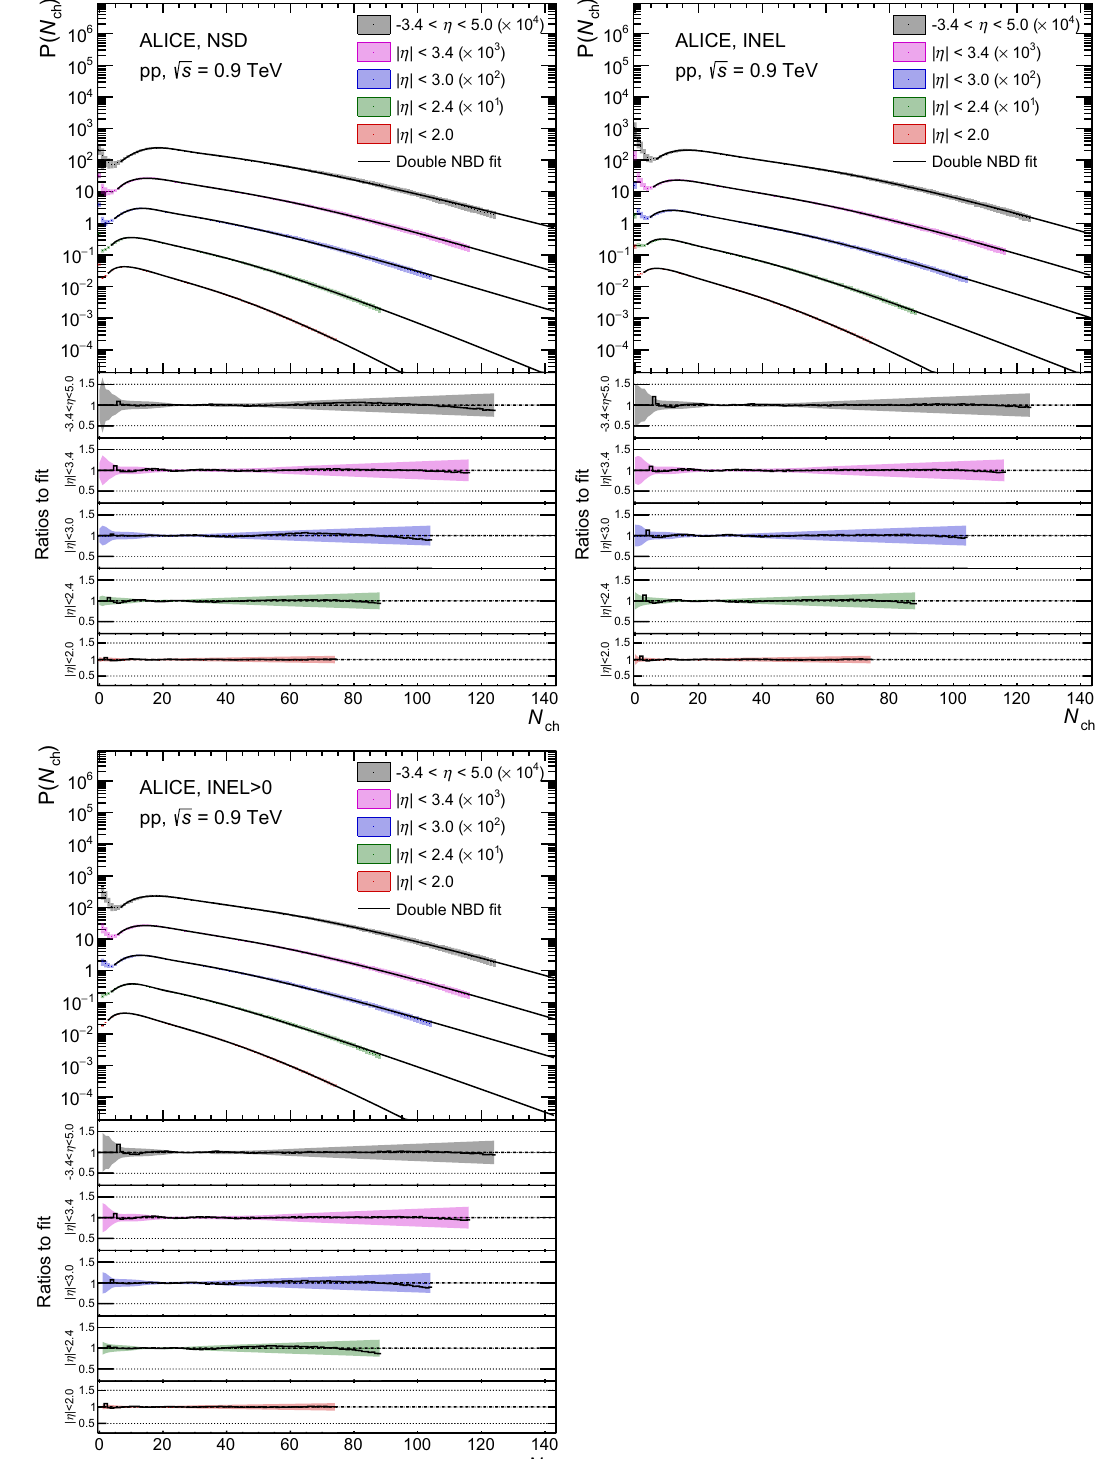
Fig. 3 Charged-particle multiplicity distributions for NSD (top left), INEL (top right) and INEL > 0 (bottom) pp collisions at The lines show fits to double NBDs. Ratios of the data to the fits are also